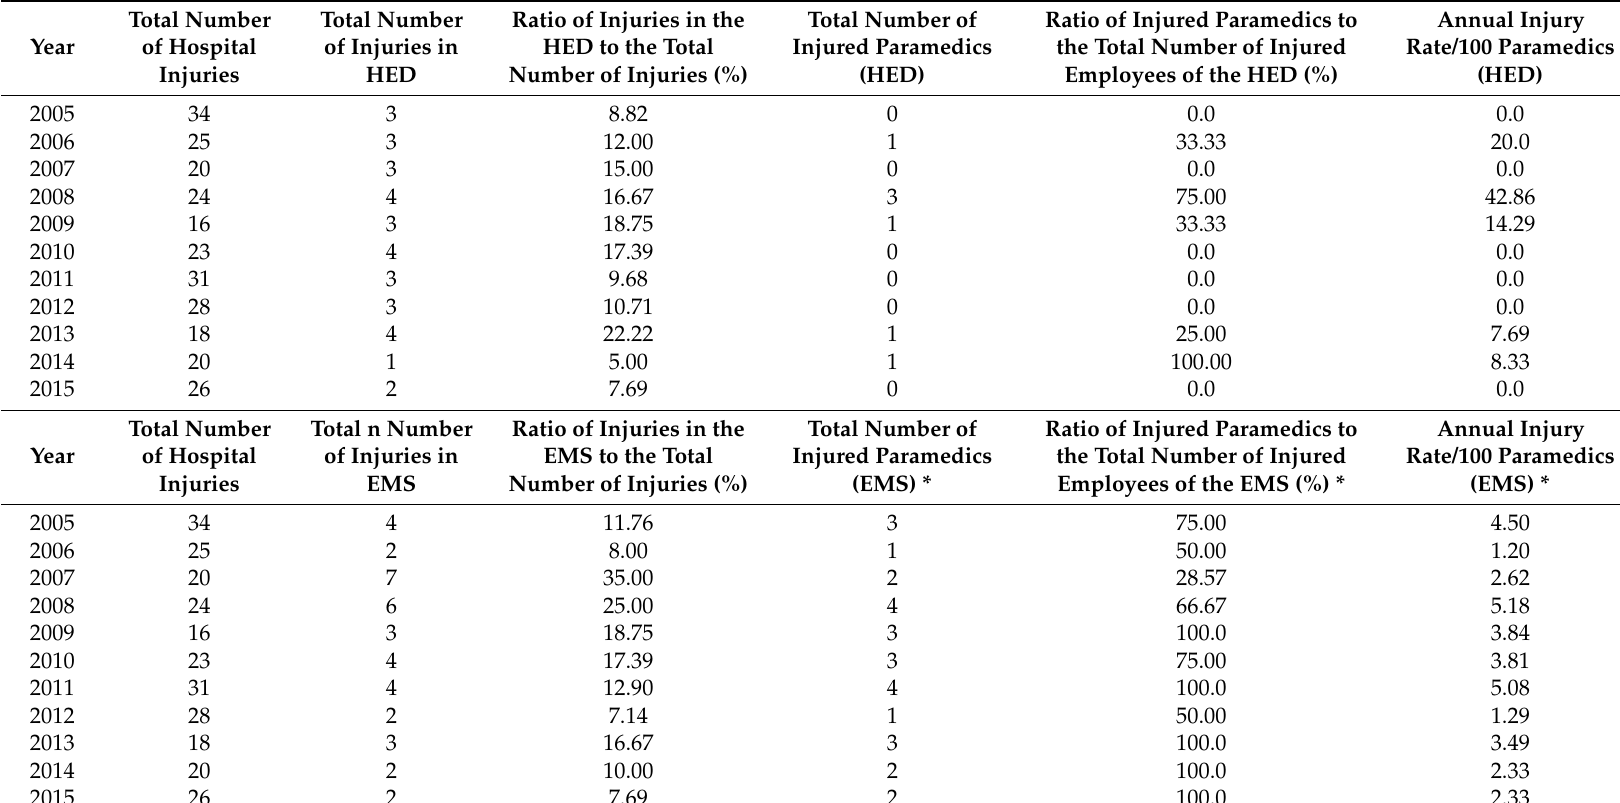
Table 5. Sharp injuries in employees of the Hospital Emergency Department and the Emergency Medical Service,